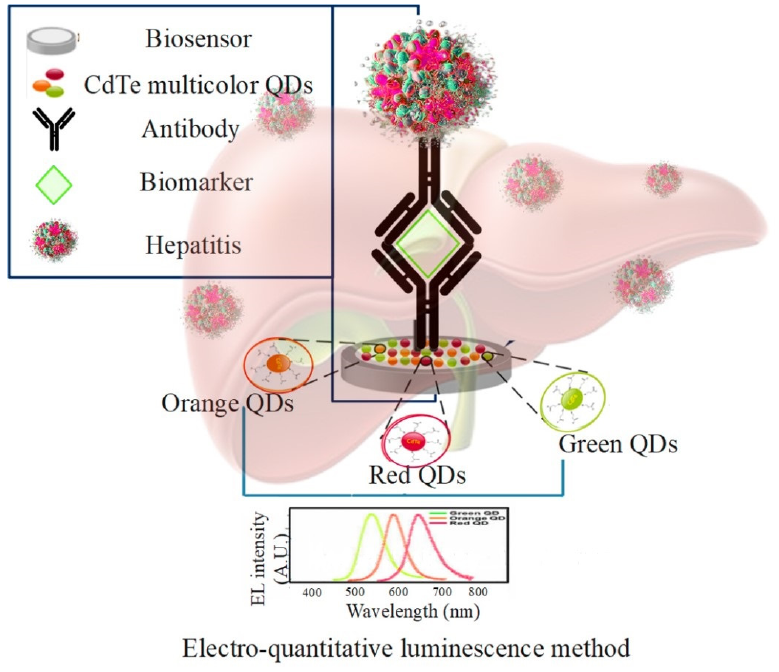
Figure 11. Detection of hepatitis C and hepatitis B virus using CdTe multicolor QDs and gold nanoparticles in the electro-quantitative luminescence